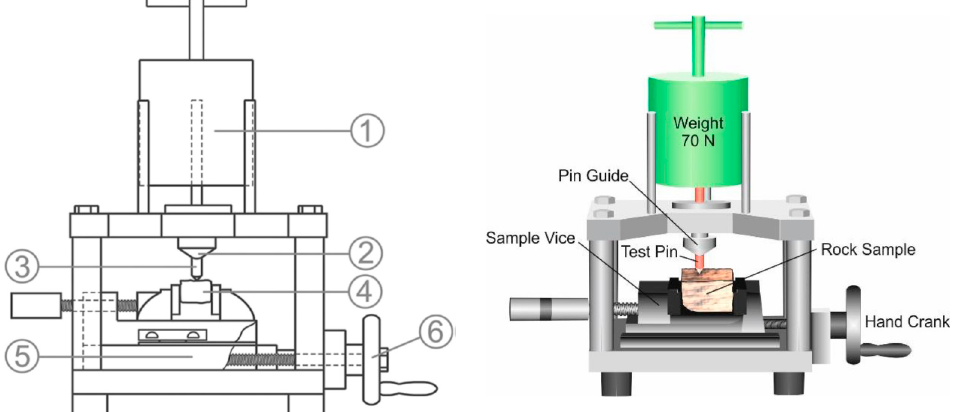
Figure 4 . Setup of a second ‐ generation Cerchar testing device [28].